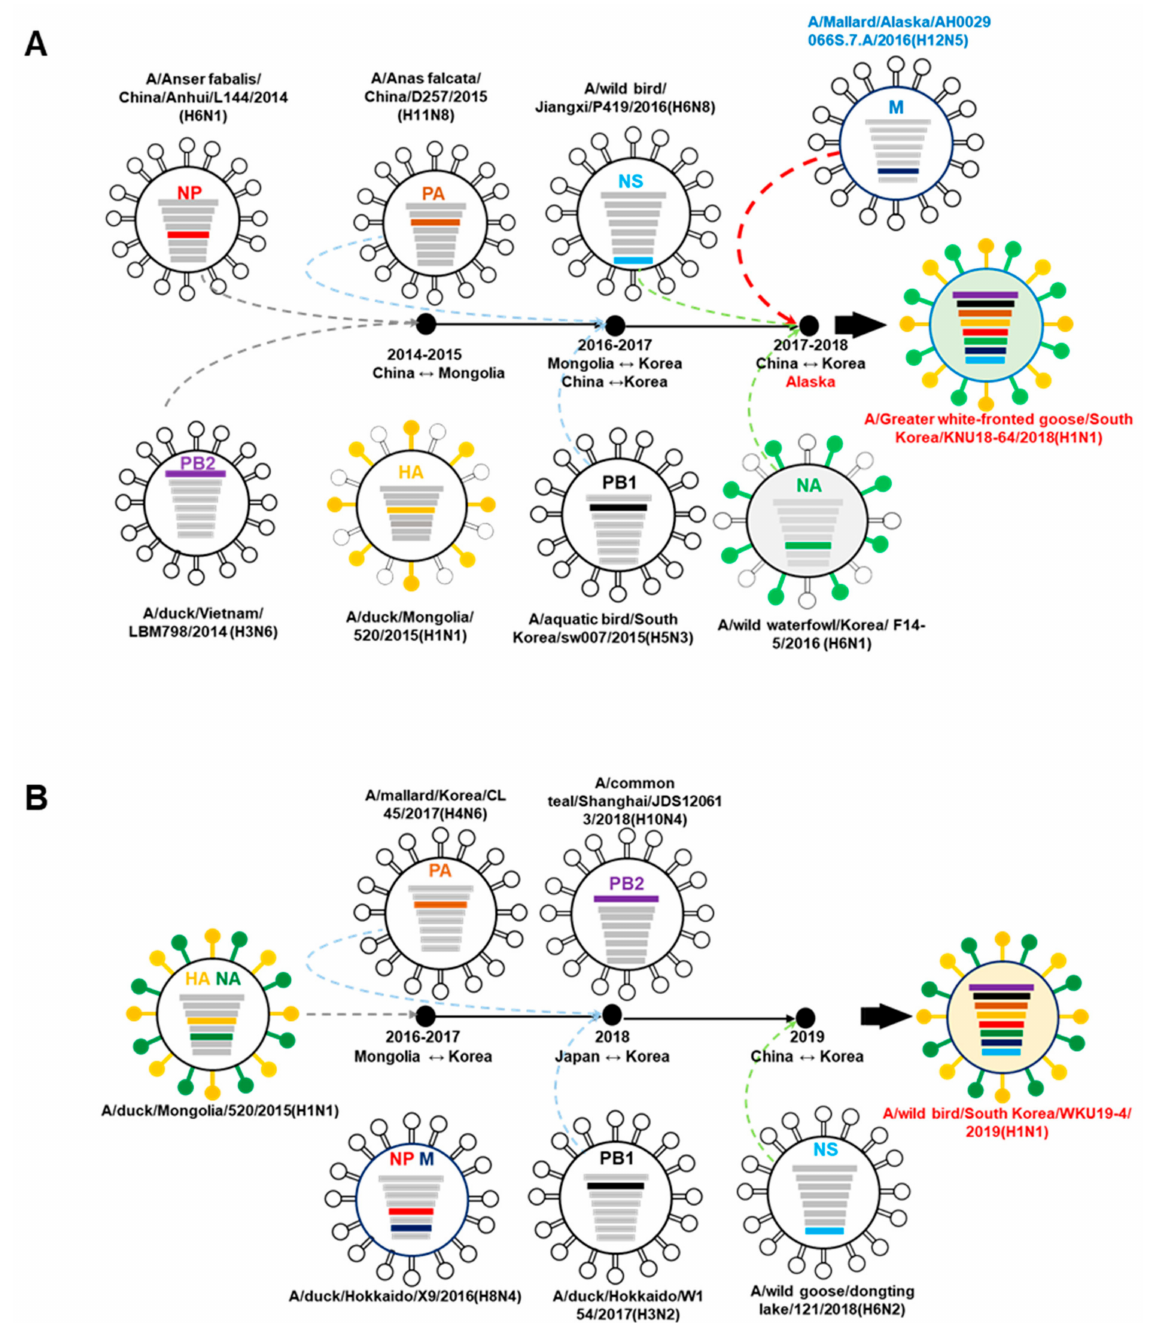
Figure 3. Hypothesis for the ancestor of each gene segment evolution of KNU18-64 (A/ Greater white-fronted goose /South Korea/KNU18-64/2018(H1N1)) ( A ) and WKU19-4 (A/wild bird/South Korea/WKU19-4/2019(H1N1)) ( B )